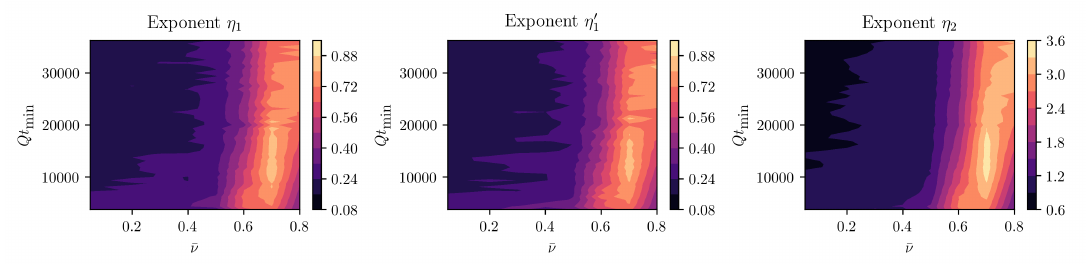
Figure 7: Persistent homology scaling exponents at Qt